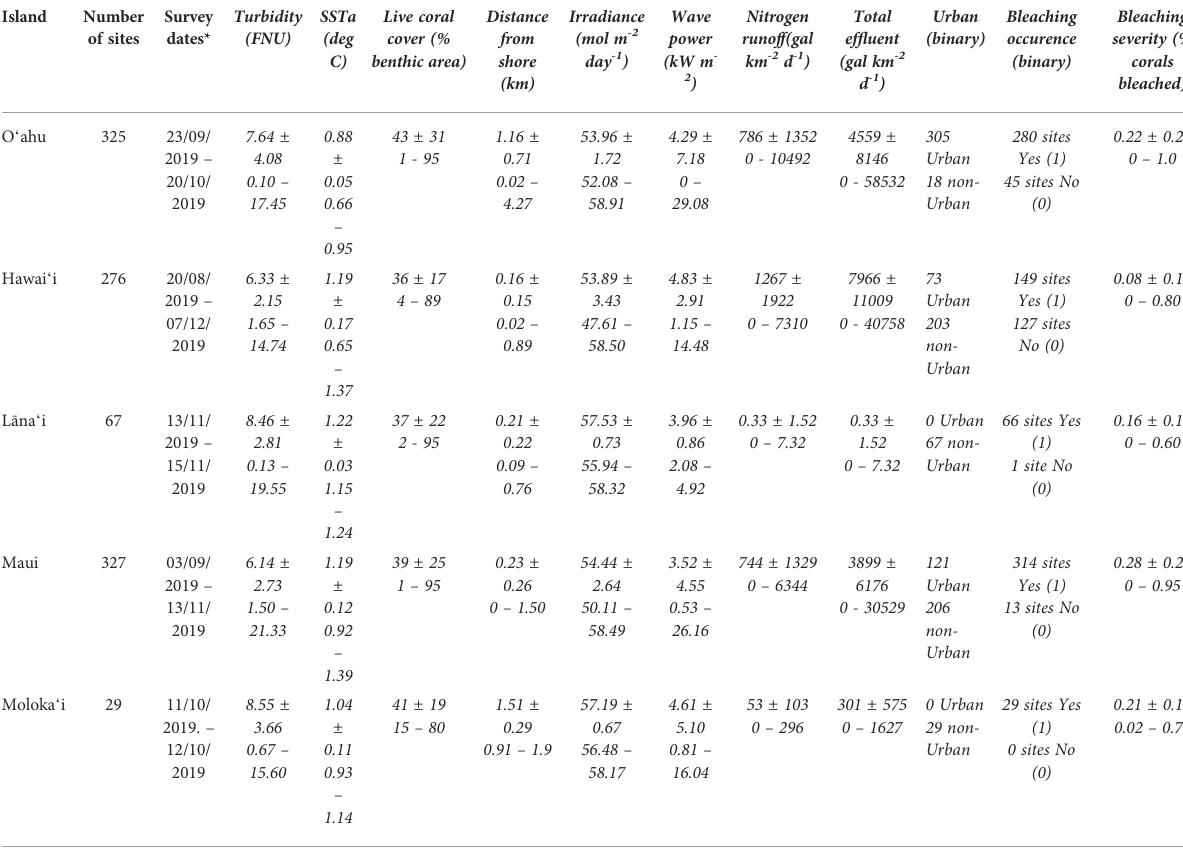
TABLE 1 Mean, standard deviation, and range of unstandardized variables per island. Island Number Survey Turbidity of sites dates*